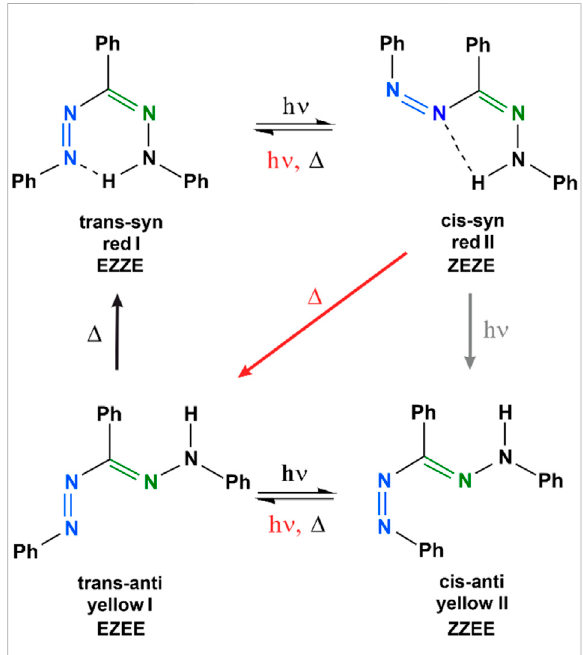
FIGURE 1 The two most prominent photoisomerization schemes of TPF after excitation, as introduced by Kuhn and Weitz (Kuhn and Weitz,1953)andbyGrummtandLangbein(GrummtandLangbein, 1981).Black arrows andsymbols indicatepathwayspresentin both models, while gray elements are only found in the Kuhn- Weitz scheme and red elements only in the Grummt-Langbein scheme, respectively. The nomenclature, e.g., trans-syn, corresponds to the N=N double bond (blue) and the C=N double bond (green). Theorientation oftheadjacentC – N andN – Nsingle bonds will be discussed in Section